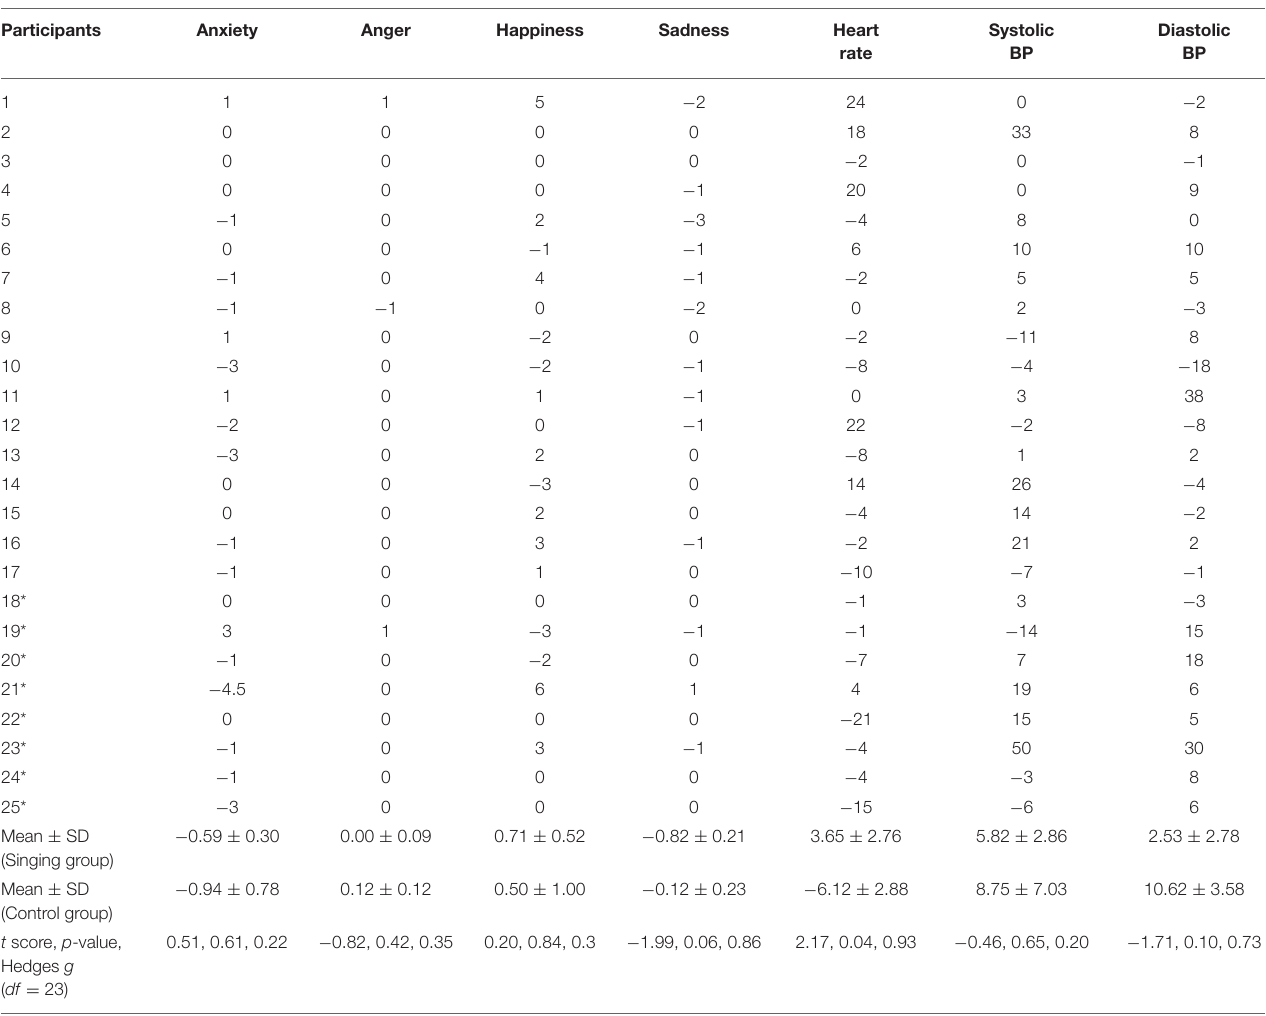
TABLE 2 | Change scores for subjective mood ratings, heart rate, and blood pressure. Participants Anxiety Anger Happiness Sadness Heart